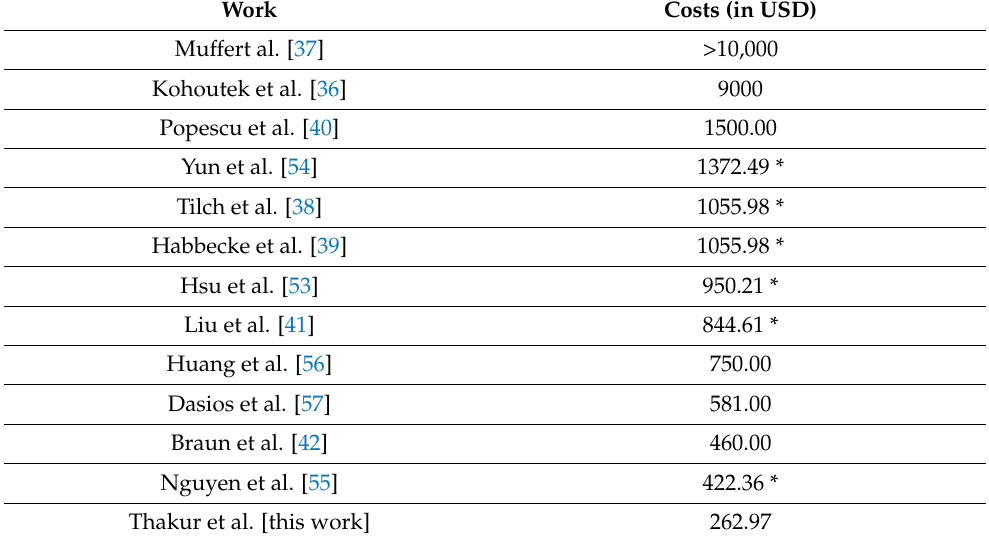
Table 4. Comparison of the costs of our system with the cost of the systems proposed in prior works in this field. Here, by costs, we refer to only the cost of